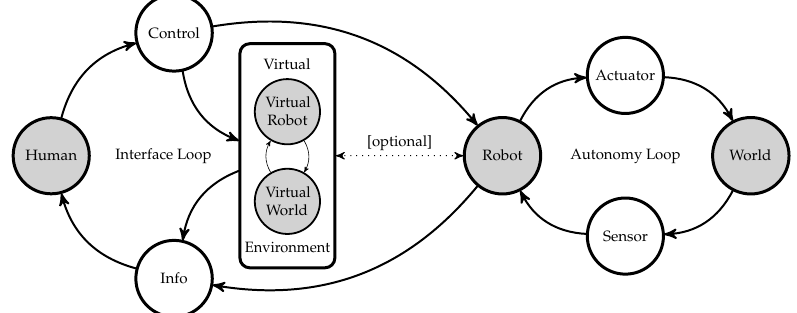
Figure 4. Virtual reality robot operation (inspired by the remote robot operation by Crandall et al.